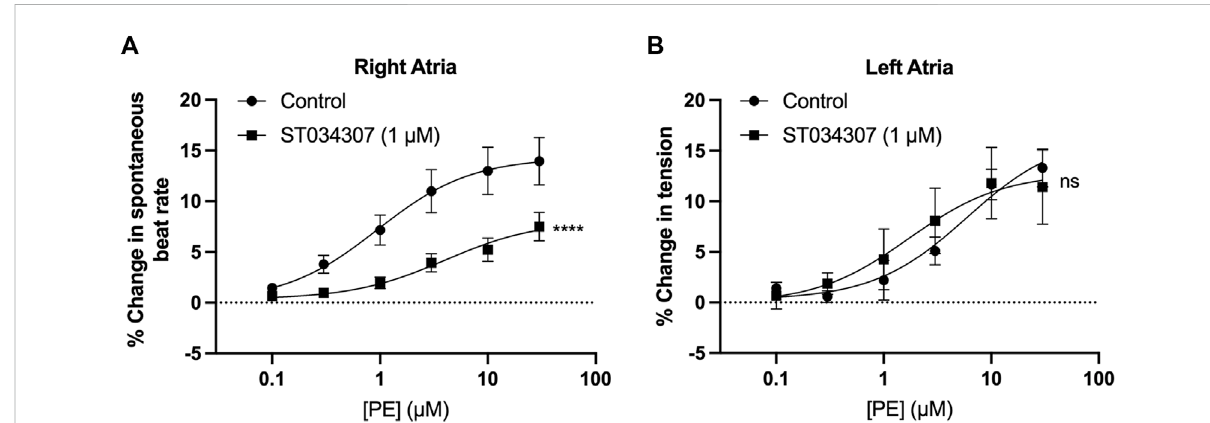
FIGURE 1 1 µMST034307inhibitschangesinchronotropyinintactmouserightatriawithintactSANbutnotinotropyinleftatria. (A) Doseresponsecurves to show the change in beating rate on cumulative addition of PE to spontaneously beating mouse right atria preparations under control conditions (circles, n = 15) and in the presence of 1 µM ST034307 (squares, n = 12). (B) Dose response curves to show the change in tension generated on cumulative addition of PE to mouse left atria preparations under control conditions (circles, n = 5) and in the presence of 1 µM ST034307 (squares, n =7).Dose-responsecurvesin (A,B) (solidlines)were fi ttedusinglog(agonist)vs.response(three-parametermodel)usingGraphpadPrism v9.Asterisksindicatesigni fi cancelevelforeffectofST034307comparedtocontrolatindividualconcentrations asdeterminedusing2-wayrepeated measures ANOVA followed by Š ídák ’ s multiple comparisons test. Data are represented as mean ± SEM; ns = not signi fi cant; *, p < 0.05; **, p < 0.01; ***, p <